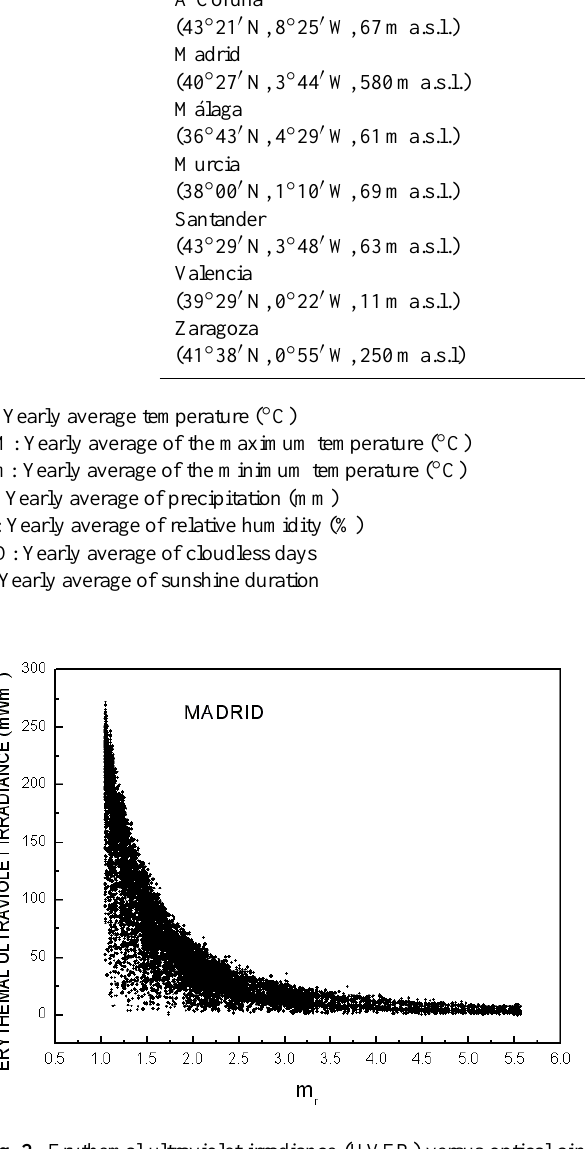
Fig. 2. Erythemal ultraviolet irradiance (UVER) versus optical air mass ( m r ) at Figure 2: Erythemal ultraviolet irradiance (UVER) versus optical air mass (m r ) at Madrid.